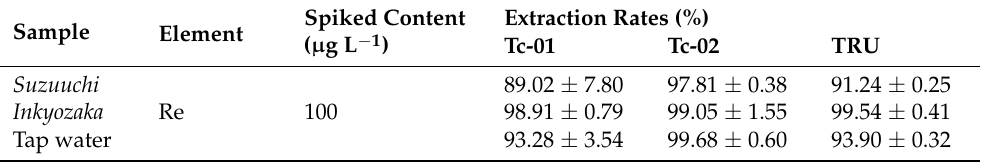
Table 2. Validation of Re-separation protocols with ECRs at optimized conditions.